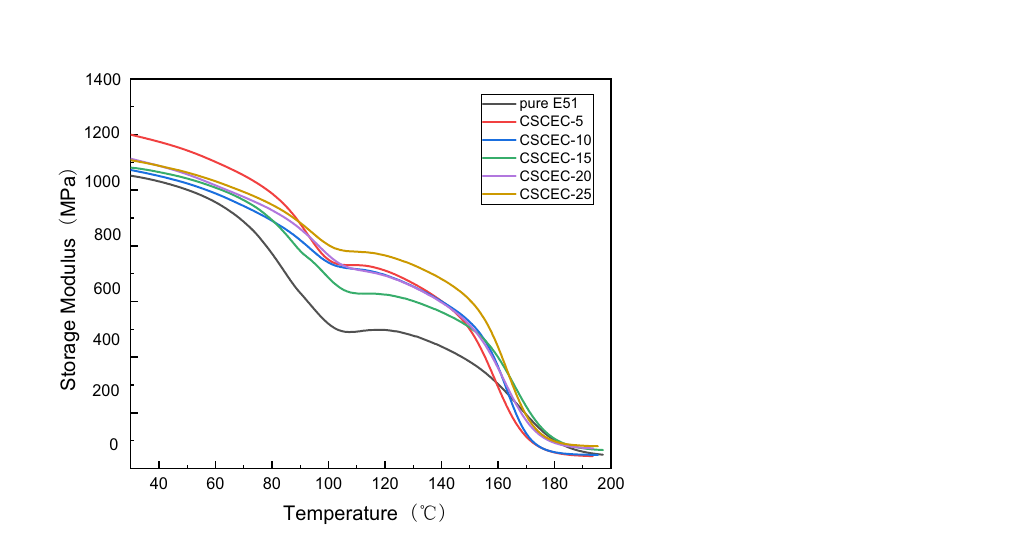
Figure 5. Storage modulus-Temperature curves of the